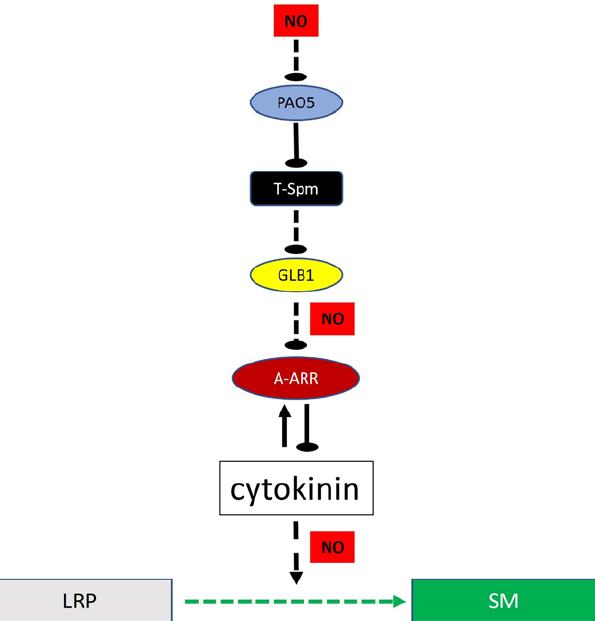
Figure 8. A hypothetical model showing how the Arabidopsis polyamine oxidase 5 (AtPAO5) might influence the cytokinin-induced conversion of lateral root primordia (LRPs) into shoot meristems (SMs). T-Spm—thermospermine; AtGLB1—class 3 haemoglobin; NO—nitric oxide; A-ARR—typeA arabidopsis response regulators. The pointed arrows indicate activation, the round-pointed ones inactivation, the dashed lines indicate indirect interaction.